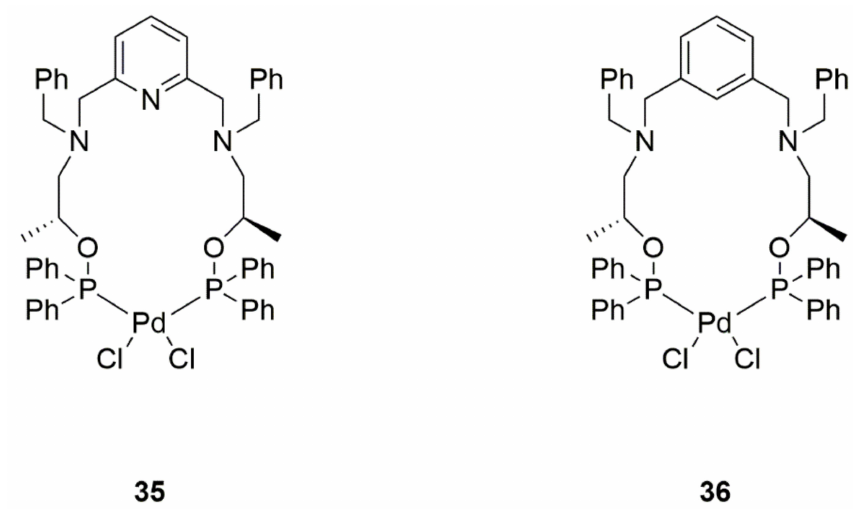
Figure 15. Structures of bis(phosphinite) palladium(II) complexes.